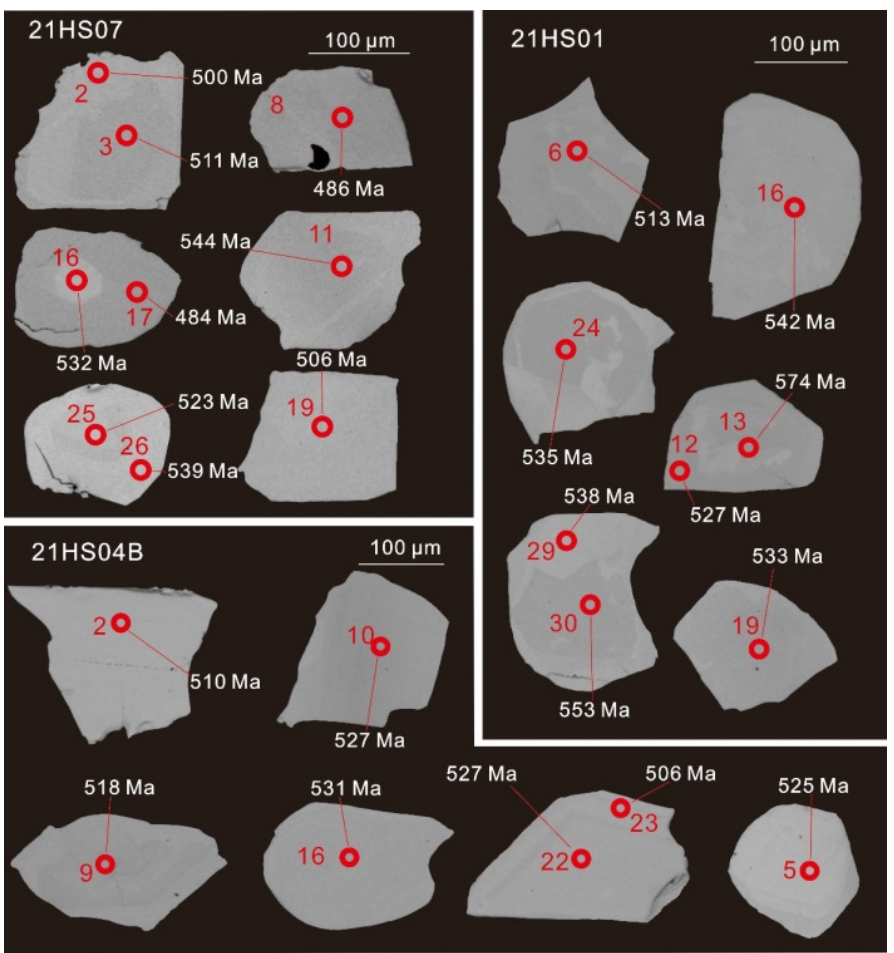
Figure 6. Representative Cathodoluminescence (CL) images of monazite grains from biotite granitic gneiss (21HS01), syeno-granite (21HS07), and syeno-granitic pegmatite (21HS04B).